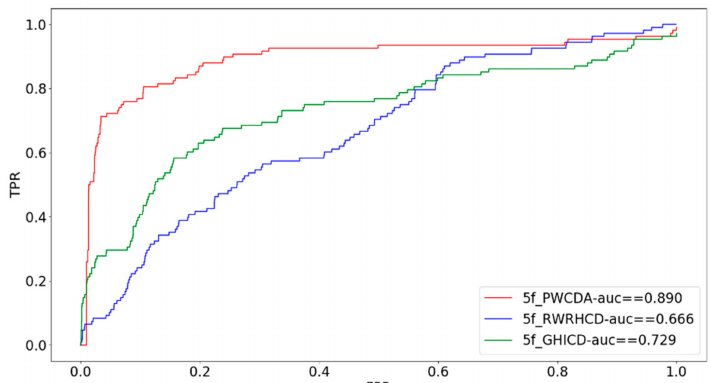
Figure 2. Comparison of PWCDA with other computational methods via five-fold cross validation.